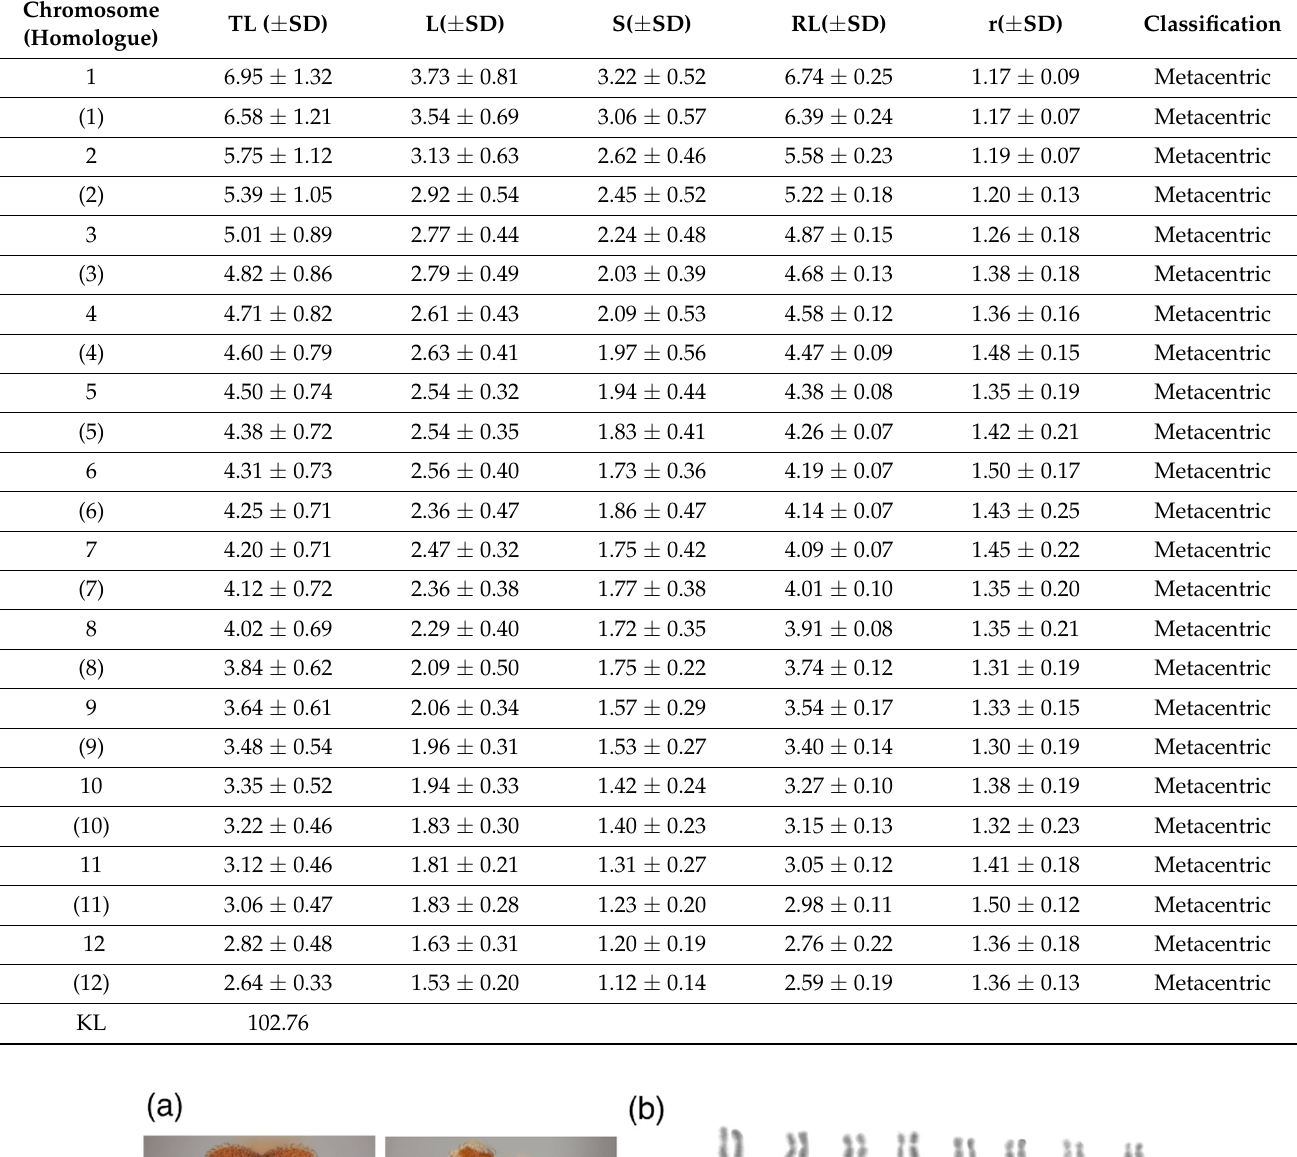
Table 4. Karyomorphometric analyses of the chromosomes of Apterostigma madidiense . All measurements are given in “ µ m”. TL: total length; L: long arm length; S: short arm length; RL: relative length; r: arm ratio; KL: karyotype length.